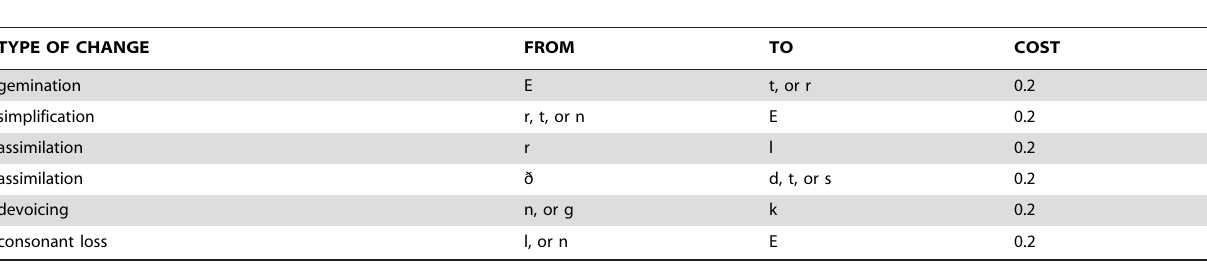
Table 3. Examples of edit-distance transformations and their associated cost.